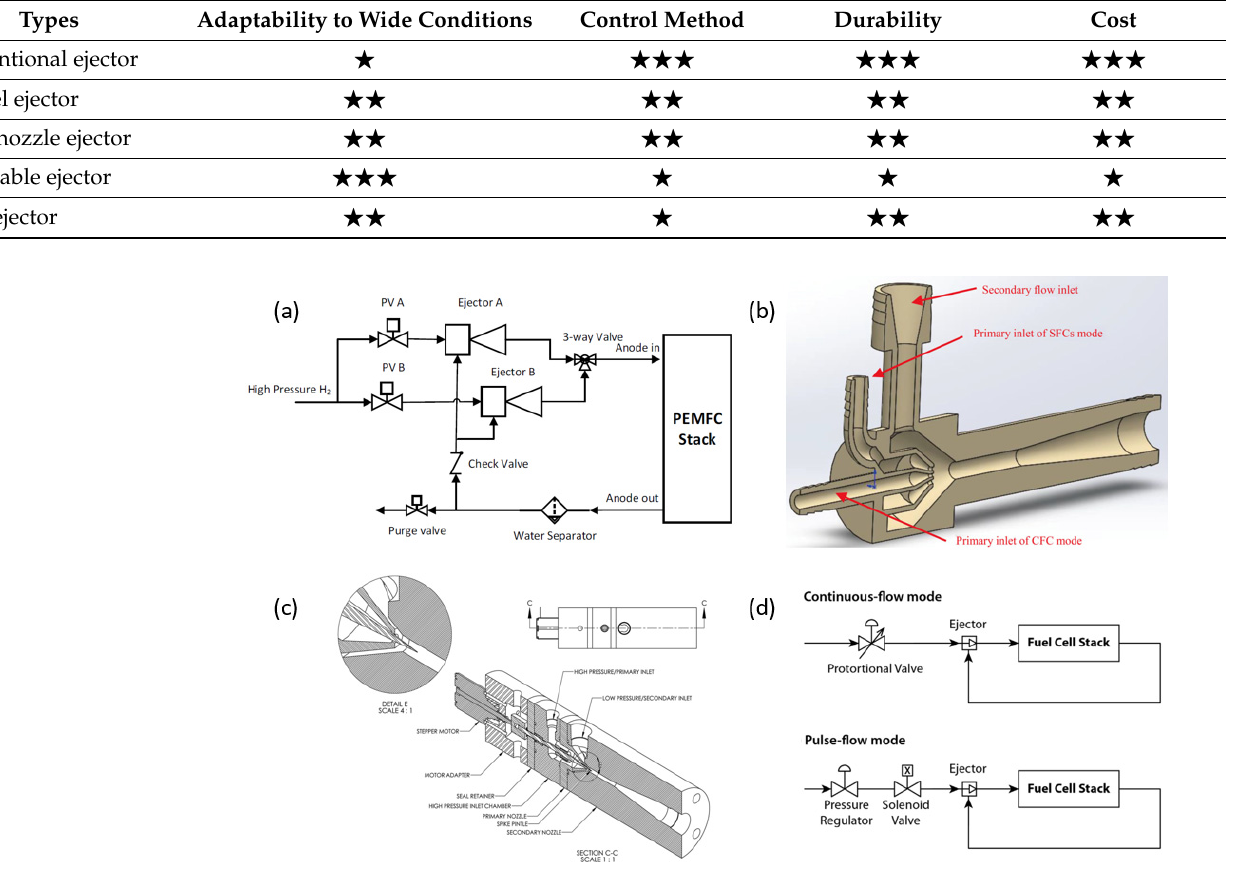
Figure 5. Schematic diagram of different types of ejectors: ( a ) parallel ejector [37], ( b ) multi-nozzle